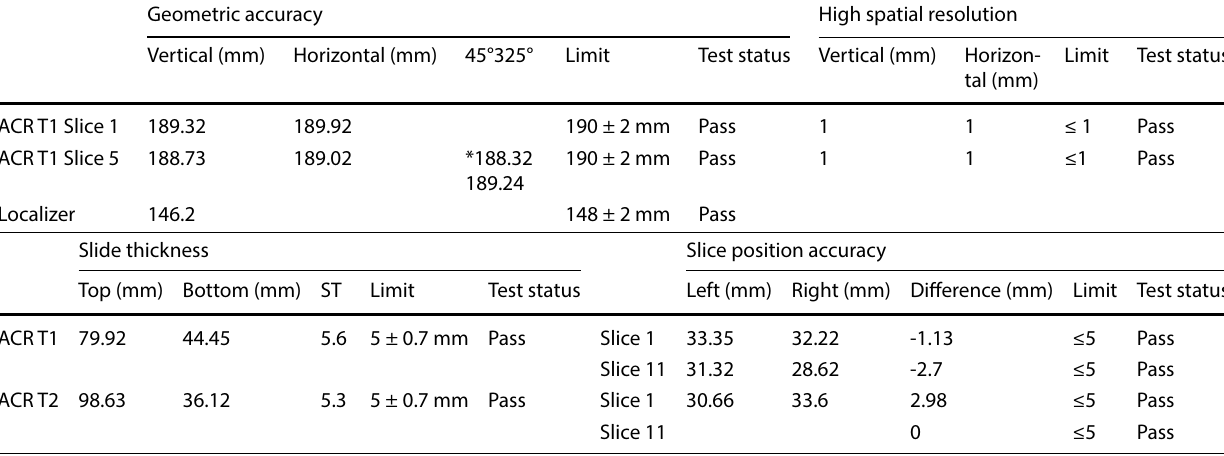
Table 3 Summary of results for geometric accuracy, high spatial resolution, slide thickness, and slice position accuracy on a 3.0 T Philips scanner Geometric